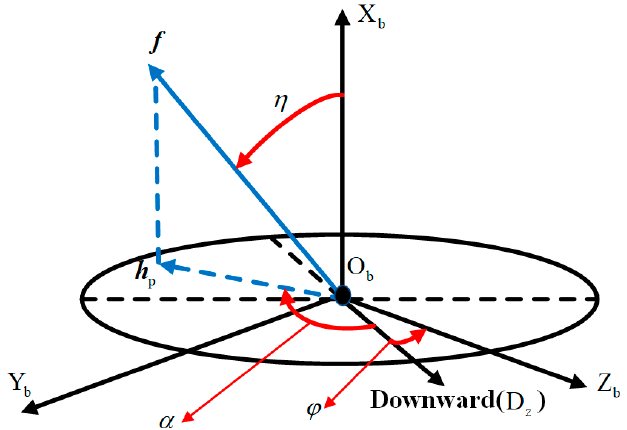
Figure 18. Cross-section and geomagnetic vector.